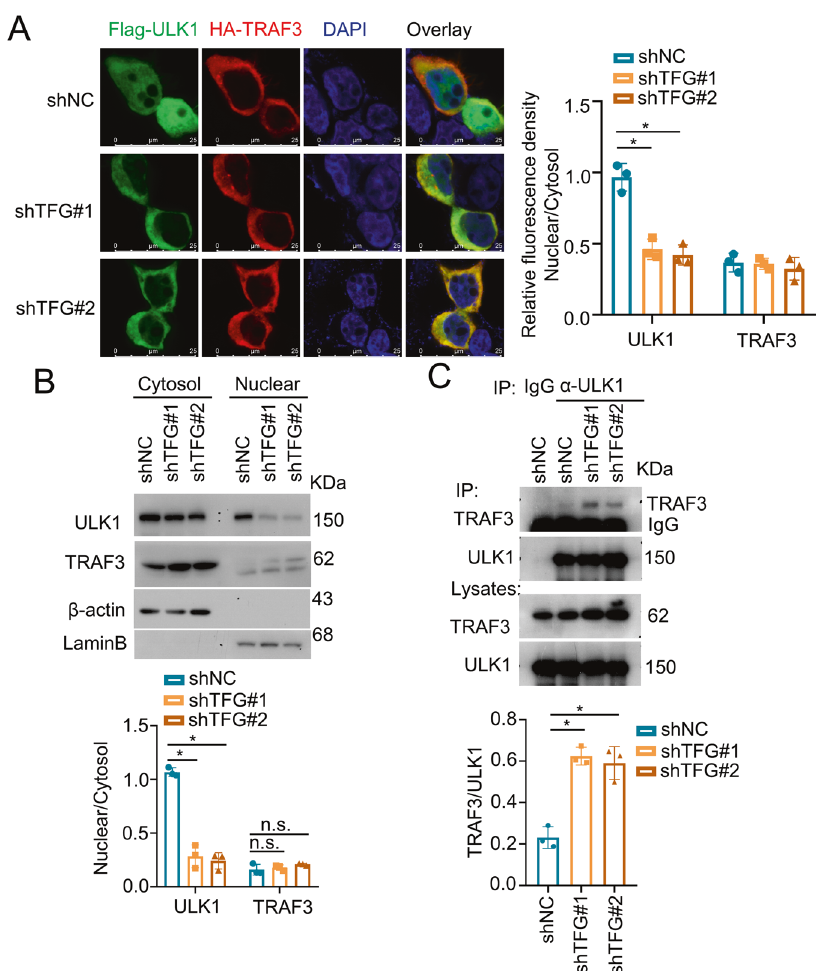
Fig. 5 TFG regulates ULK1 subcellular localization. A HEK293 cells were transduced with a nontargeting control shRNA (shNC) or TFG- speci fi c shRNAs. Cells were transfected with Flag-ULK1 and HA-TRAF3. Colocalization of overexpressed Flag-ULK1 (green) and HA-TRAF3 (red) were analyzed by confocal microscopy. Nuclear was visualized by DAPI staining (blue). Right panel shows relative fl uorescence density of nuclear/cytosol ratio of ULK1 and TRAF3. Data are shown as mean ± s.d. * p < 0.05; n = 3 for each group. B THP-1 cells were transduced with shNC or TFG-speci fi c shRNAs. Nuclear and cytosol fractions from THP-1 cells were extracted and subjected to IB using anti-ULK1 and anti- TRAF3 antibodies. Lower panel shows nuclear/cytosol ratio of ULK1 and TRAF3. Data are shown as mean ± s.d. * p < 0.05; n.s. no signi fi cance. C Co-IP assay of endogenous ULK1 and TRAF3 in control or TFG-speci fi c knockdown THP-1 cells. Lower panel shows TRAF3/ULK1 ratio in which indicates binding activity. Data are shown as mean ± s.d. * p < 0.05; n = 3 for each group. Experiments were independently repeated three